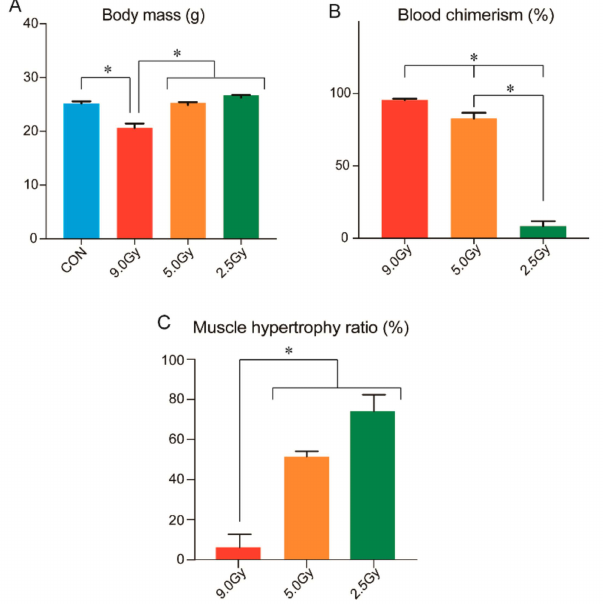
Figure 2. Body mass, BMI rate, and muscle hypertrophy capacity in the three TBI groups. ( A ): Significant decrease in body mass was only present in the 9.0 Gy group compared to the other three groups. ( B ): GFP+ peripheral blood, indicative of chimerism and mononucleated cells. Almost no TBI effects were observed in the 2.5 Gy group. However, significant differences were observed in each three groups. ( C ): Muscle hypertrophy capacity. Values were set at 100% of the normal control value. CON = control group; * p < 0.05.